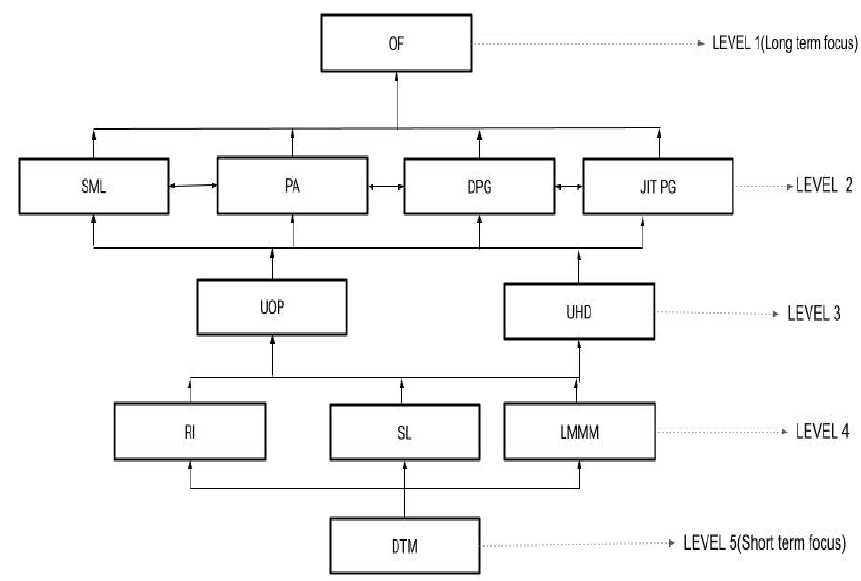
Figure 2. Interpretive structural model.